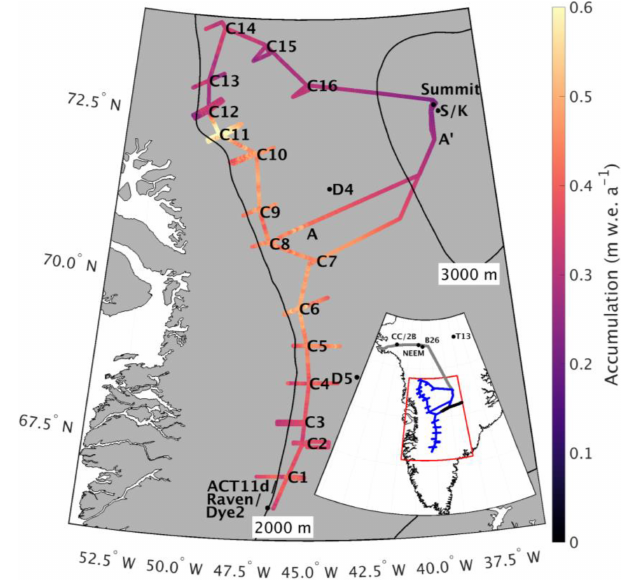
Figure 1. Average accumulation rates across the GreenTrACS tra- verse for the length of each record showing the location of each firn core, ACT11d, D4, D5, Katie (K), Raven–Dye-2, and Sandy (S) ice cores, and Summit Station. Transect A – A (cid:48) discussed in Sect. 3.3. Inset shows locations of Camp Century (CC), 2Barrel (2B), NEEM, B26, and TUNU2013 (T13) ice cores, as well as locations of EGIG (black), GrIT (grey), and GreenTrACS (blue)